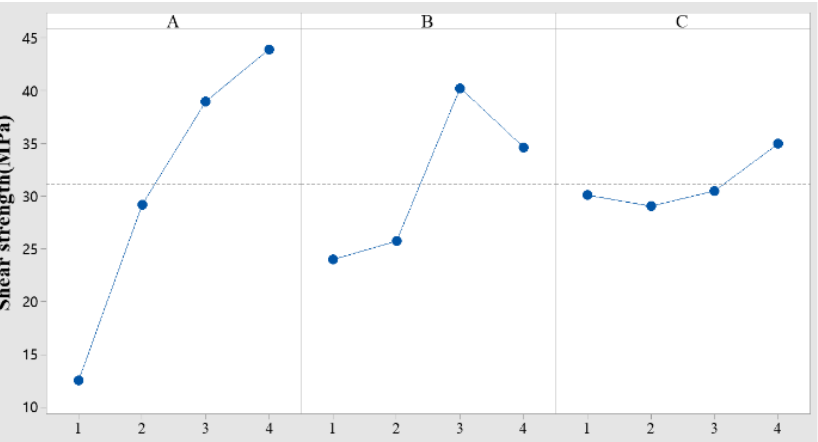
Figure 7. Effects of three factors on shear strength: ( A ) nozzle temperature; ( B ) layer thickness; ( C ) bed temperature.